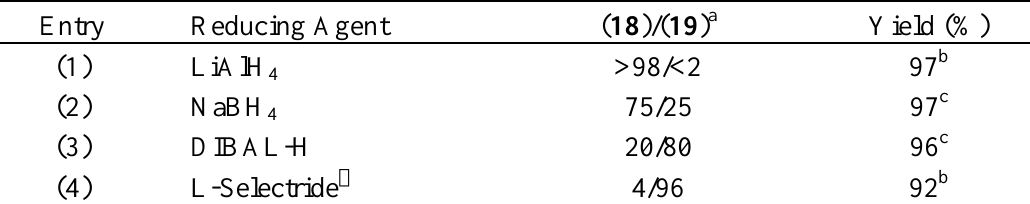
Table 2. Reduction of the tricyclic ketone ( 12